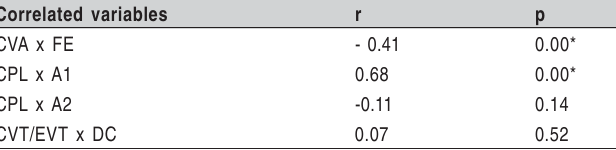
Table 3 – Correlation between craniocervical variables evaluated by cephalometry and biophotogrammetry